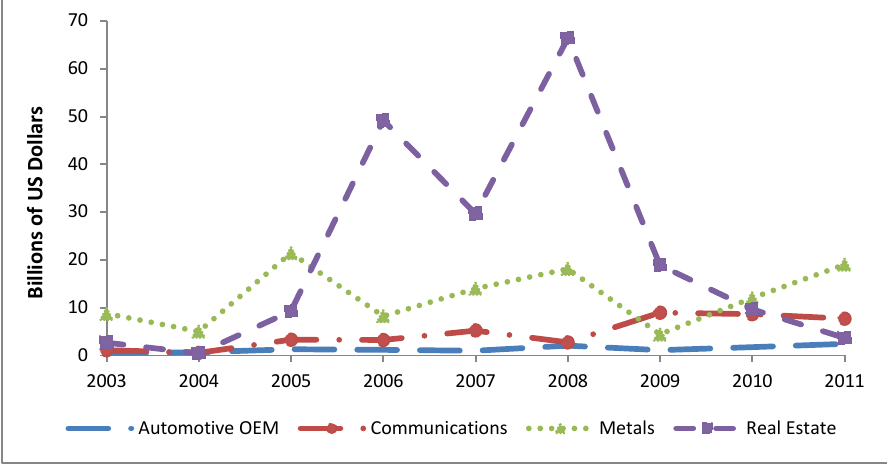
FIGURE 1: Greenfield FDI inflows – Africa